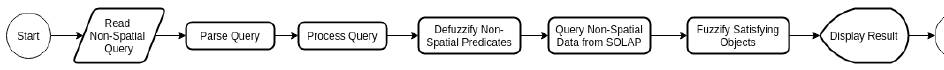
Figure 9. Fuzzy non-spatial query flow.